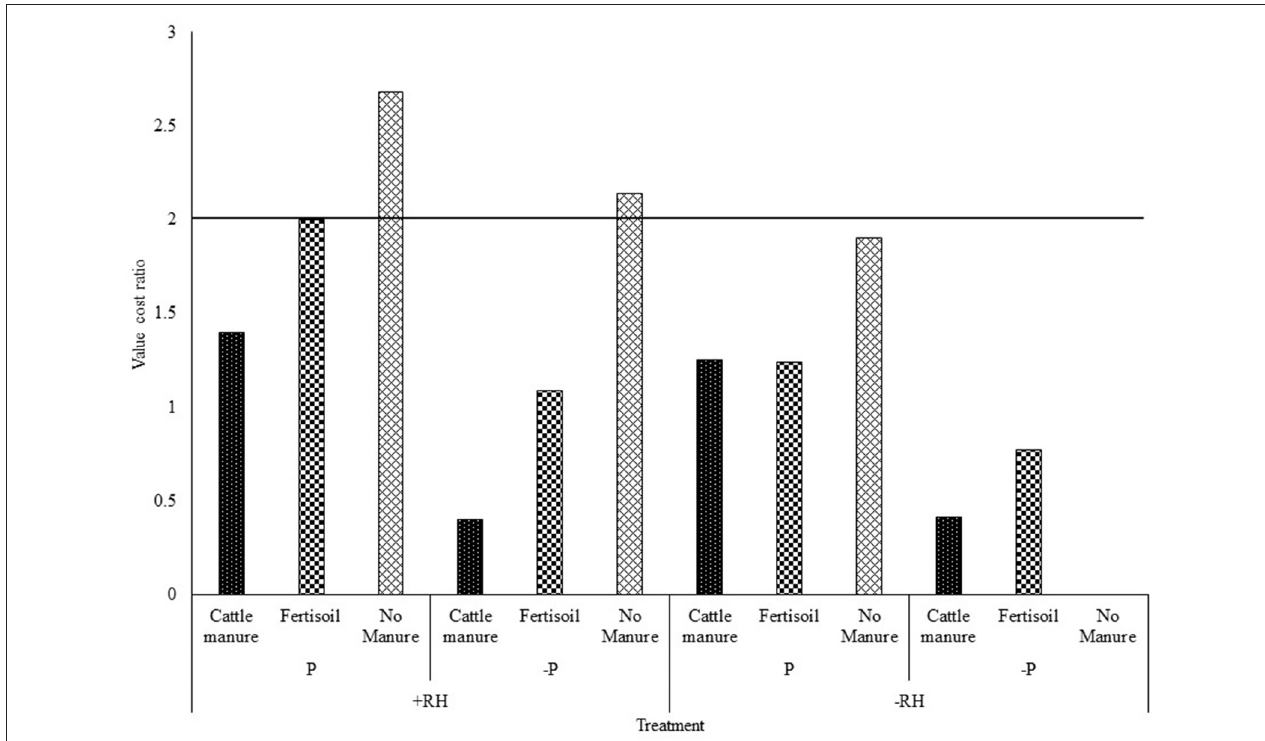
FIGURE 1 | Value cost ratio of soybean grain yield as affected by combined application of rhizobia, inoculant and organic manure.